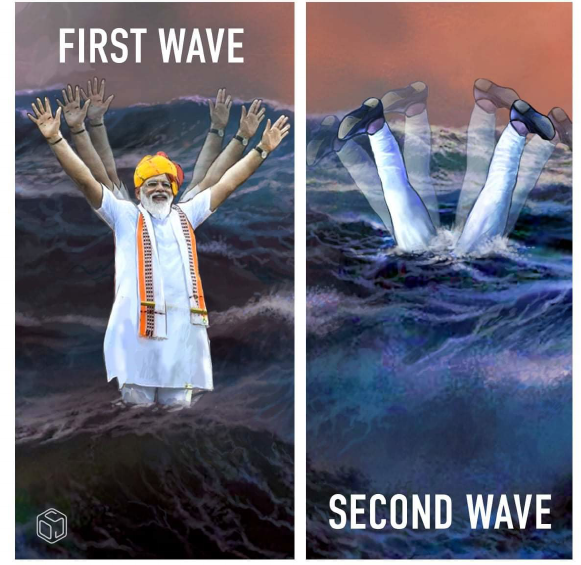
Figure 2 . A caricature of the prime minister of India during the first and second waves of COVID- 19. Image by Orijit Sen (2021), used with